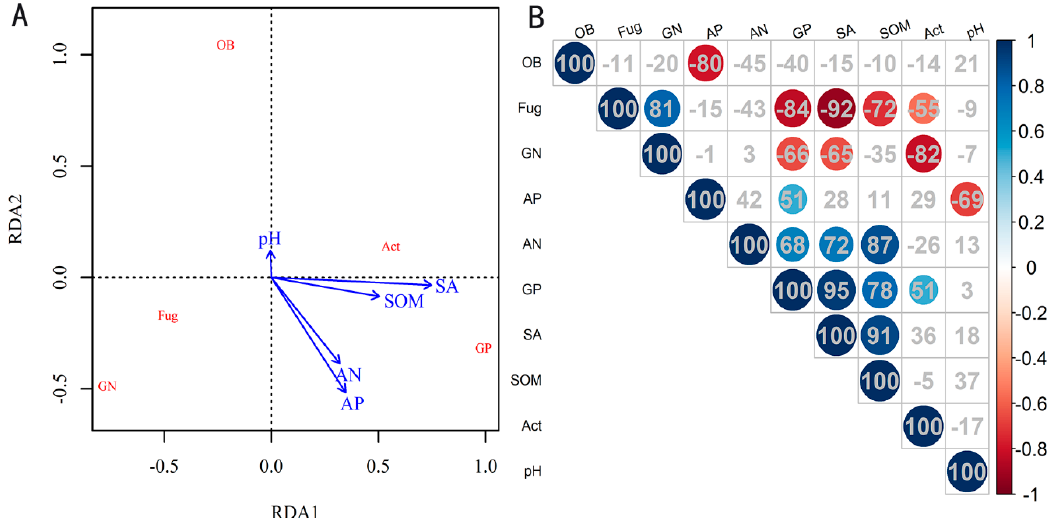
Figure 2. Effects of environmental factors on soil microbial community structure. ( A ) Redundancy analysis (RDA) of environmental factors on soil microbial community structure. ( B ) Correlation analysis of soil environmental factors and soil microbial community. GP: Gram ‐ positive bacteria; GN: Gram ‐ negative bacteria; Fug: Fungi; Act: Actinomycetes; OB: other bacteria. SA: soil macroaggregate content; AP: available phosphorus; AN: soil available nitrogen; SOM: soil organic matter.